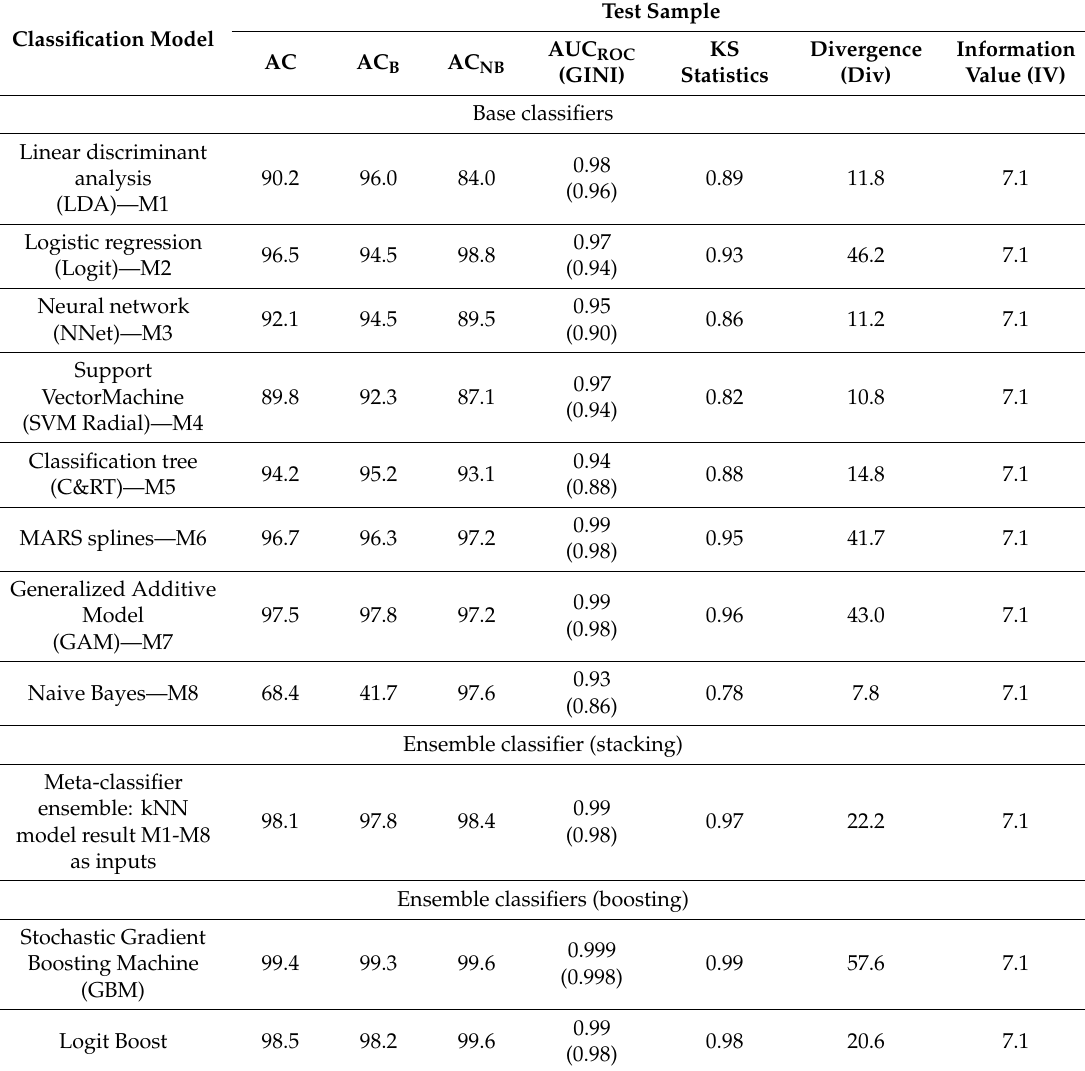
Table A3. Validation statistics for selected classical models of single bankruptcy classifiers in comparison to ensemble classifiers applied for the test / validation